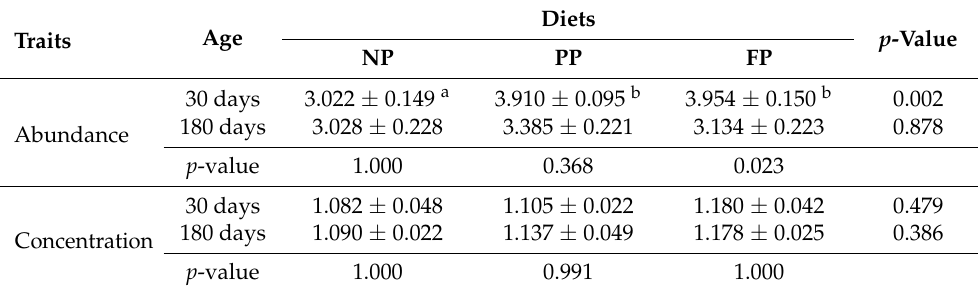
Table 6. Plasma isotope signature of calves from different treatments and periods. Traits Age